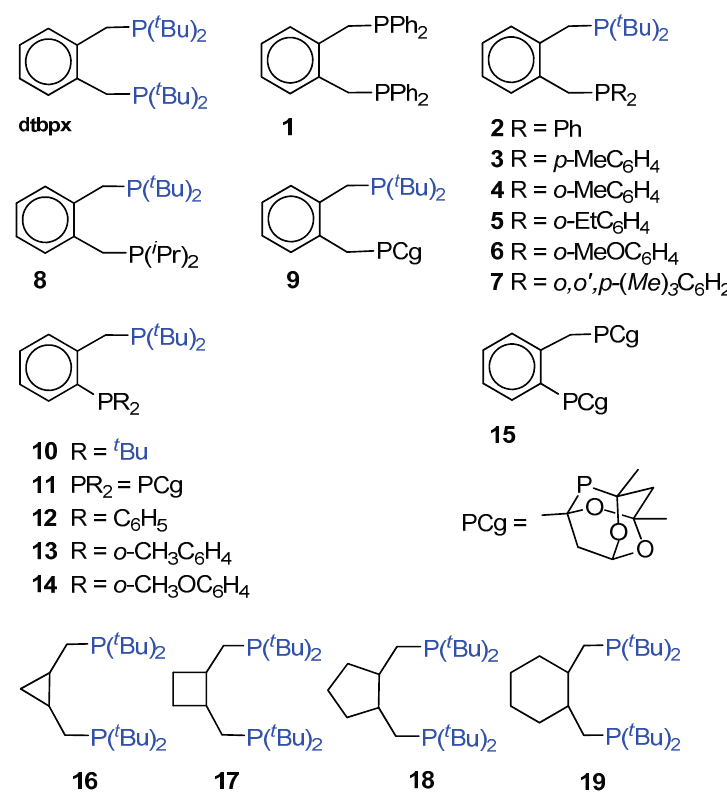
Figure 5. t Bu- and admantyl-ligands for the highly active (dtbpx and ligands 2 – 11 and 15 ) and selective (dtbpx and ligands 2 – 11 and 15 – 19 ) hydromethoxycarbonylation of